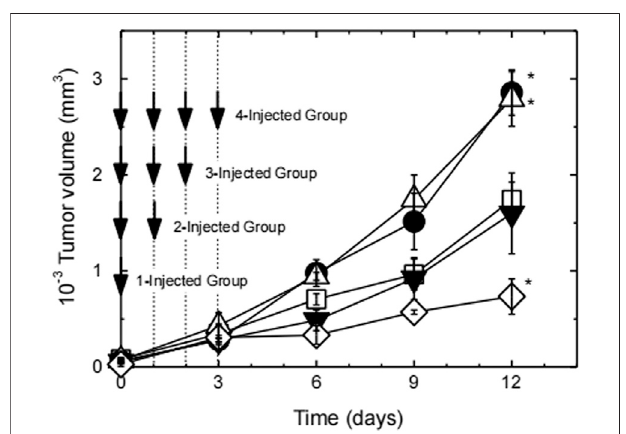
FIGURE 15 | Tumor growth curve of tumor-bearing mice after the fi rst injection of PEG-b-P(L-Arg)/m (Kudo and Nagasaki, 2015). The number of injections was changed from 1 up to 4 times on days 0 – 3 at a dose of 16 mg/kg on an arginine basis. Injection times are 1 (closed circles), 2 (open triangles), 3 (closed triangles), and 4 (open lozenges). Tumor volume change of PBS-treated mice was also shown as open squares. ( n (cid:1) 4, expressedasmean ± S.E.,* p < 0.05).Abbreviation:P(L-Arg),poly(L-Arginine); m,